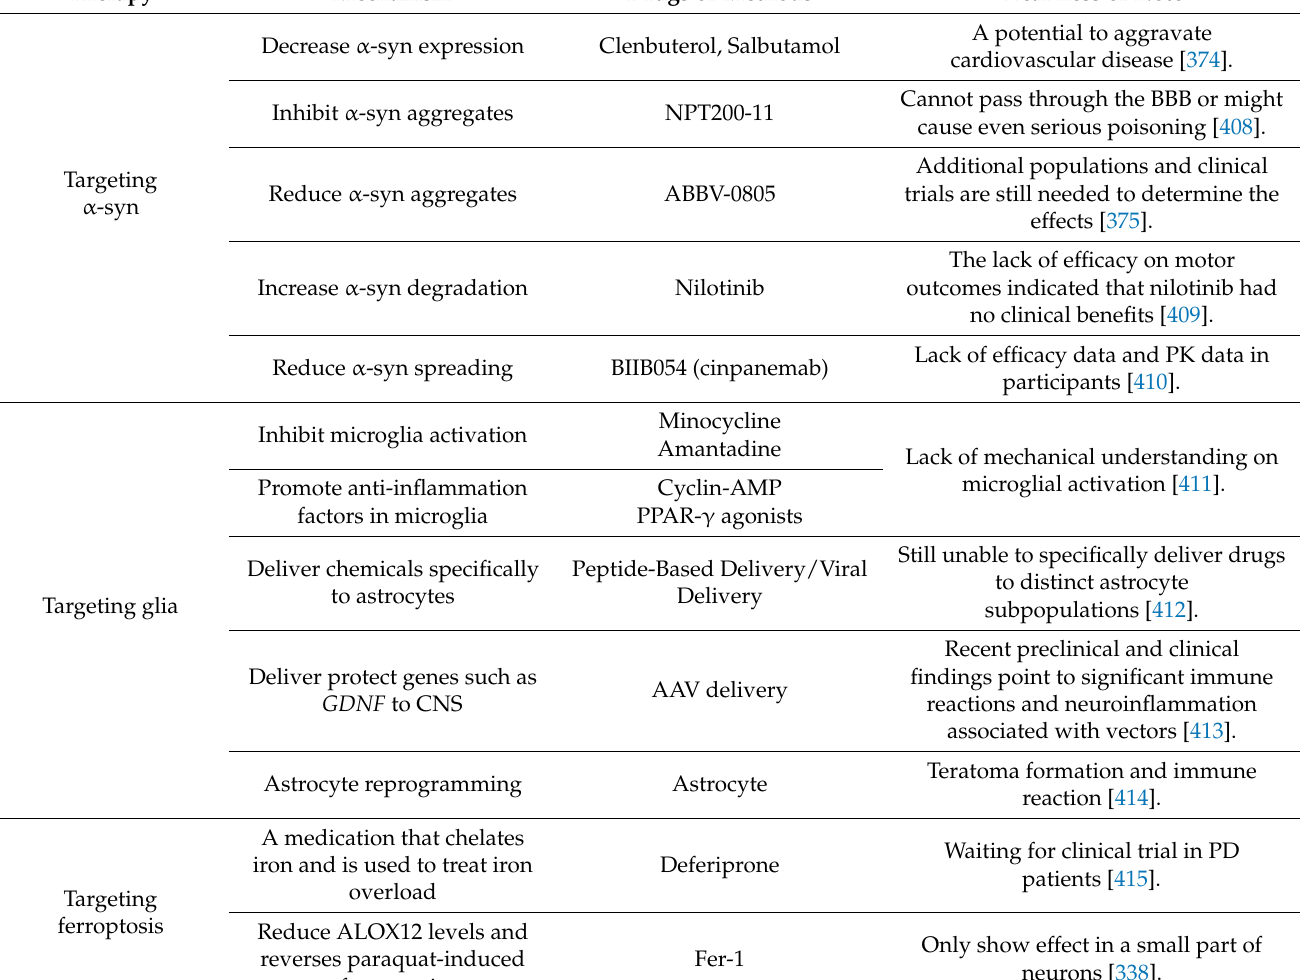
Table 2. Representative approaches for PD